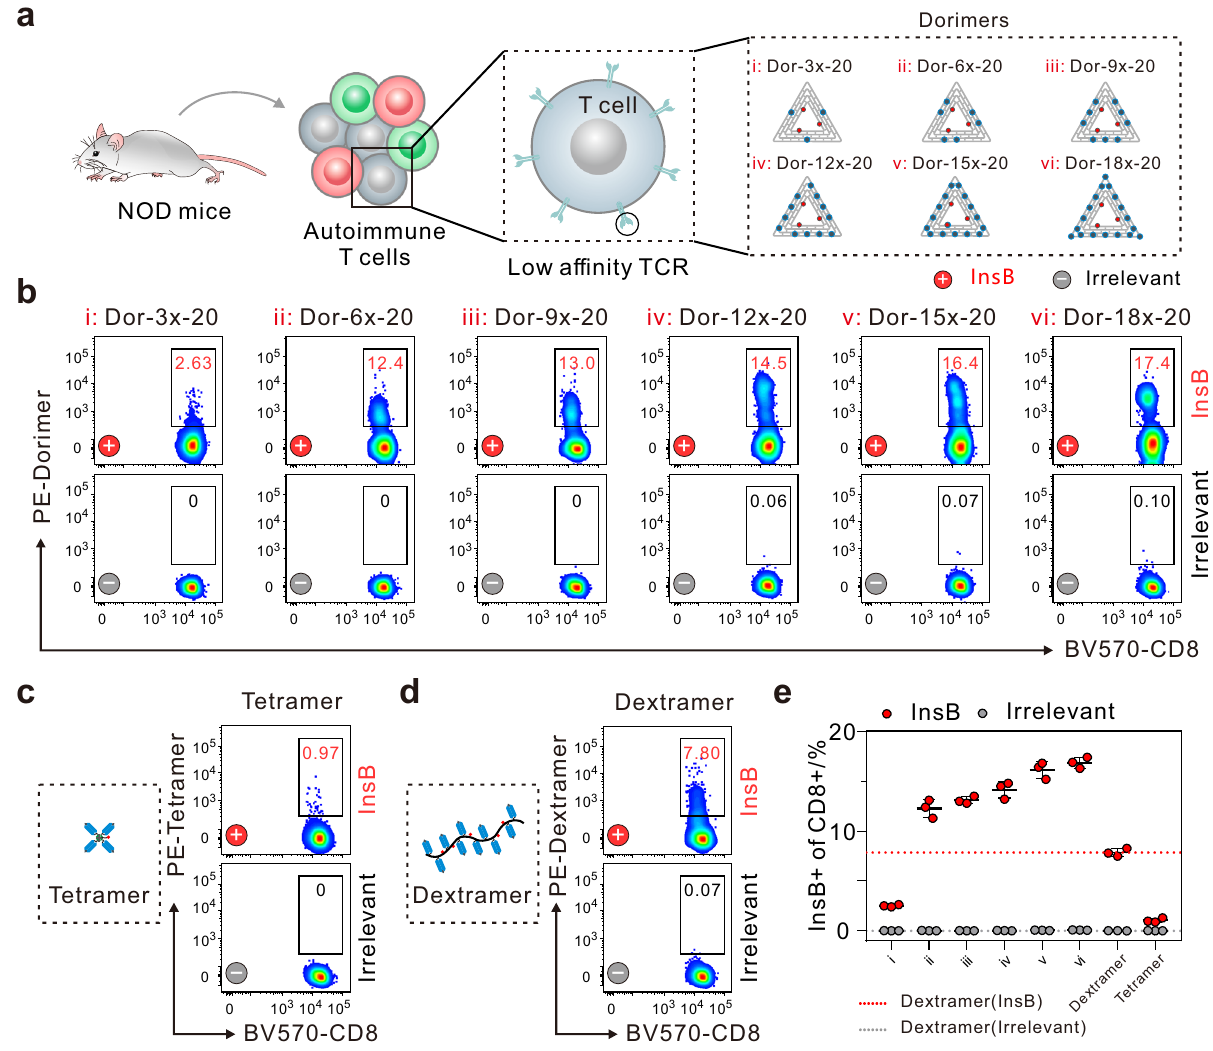
Fig. 5 Detection of autoimmune CD8 + T cells using dorimers. a Schematic illustrating phenotype analysis of InsB-speci fi c CD8 + T cells with six types of dorimers (i – vi). Antigen-speci fi c staining of InsB-speci fi c CD8 + T cells derived from the mice spleen at 8 weeks by b dorimers, c tetramer, and d dextramer at 10 nM. pMHC multimers were made using H-2K d MHC loaded with either a speci fi c InsB peptide (LYLVCGERL) ( + ) or an irrelevant TUM peptide (KYQAVTTTL) ( − ). The number in each panel represents the percentage of the identi fi ed InsB-speci fi c CD8 + T cells. e Statistical analysis of the percentages of the identi fi ed InsB-positive CD8 + T cells by dorimers, tetramer and dextramer at 10 nM. The red and gray lines represent the percentage of InsB-speci fi c CD8 + T cells detected by the InsB-/irrelevant-dextramer, respectively. Data represent the mean ± s.d. from n = 3 independent experiments. Source data are provided as a Source Data fi